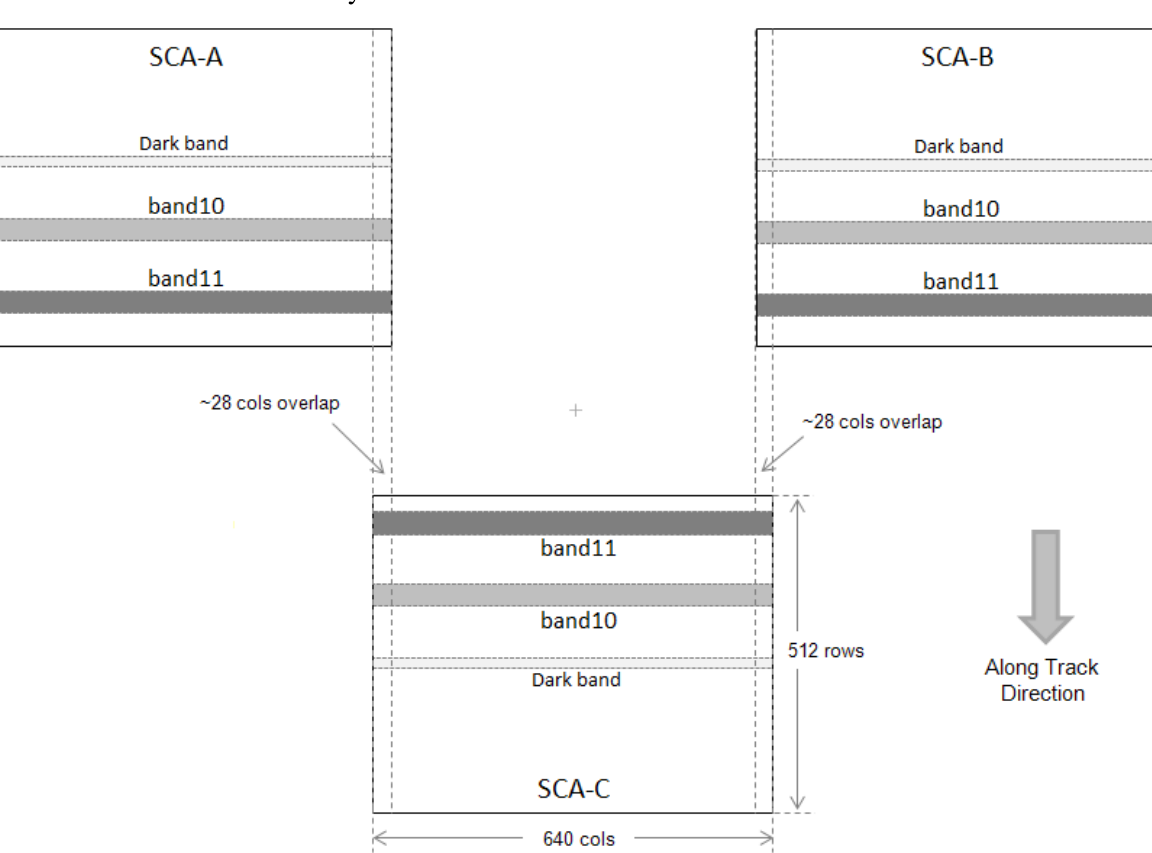
Figure 1. Thermal Infrared Sensor (TIRS) focal plane. The three arrays are known as sensor chip assembly (SCA) -A through -C. For nominal operations, two rows from each of the filtered regions centered at 10.9 µ m and 12.0 µ m (Band 10 and Band 11, respectively) are read out along with two rows from the masked, or dark region. The final image product contains data from all three arrays stitched together. An optional diagnostic mode will read out all rows from each